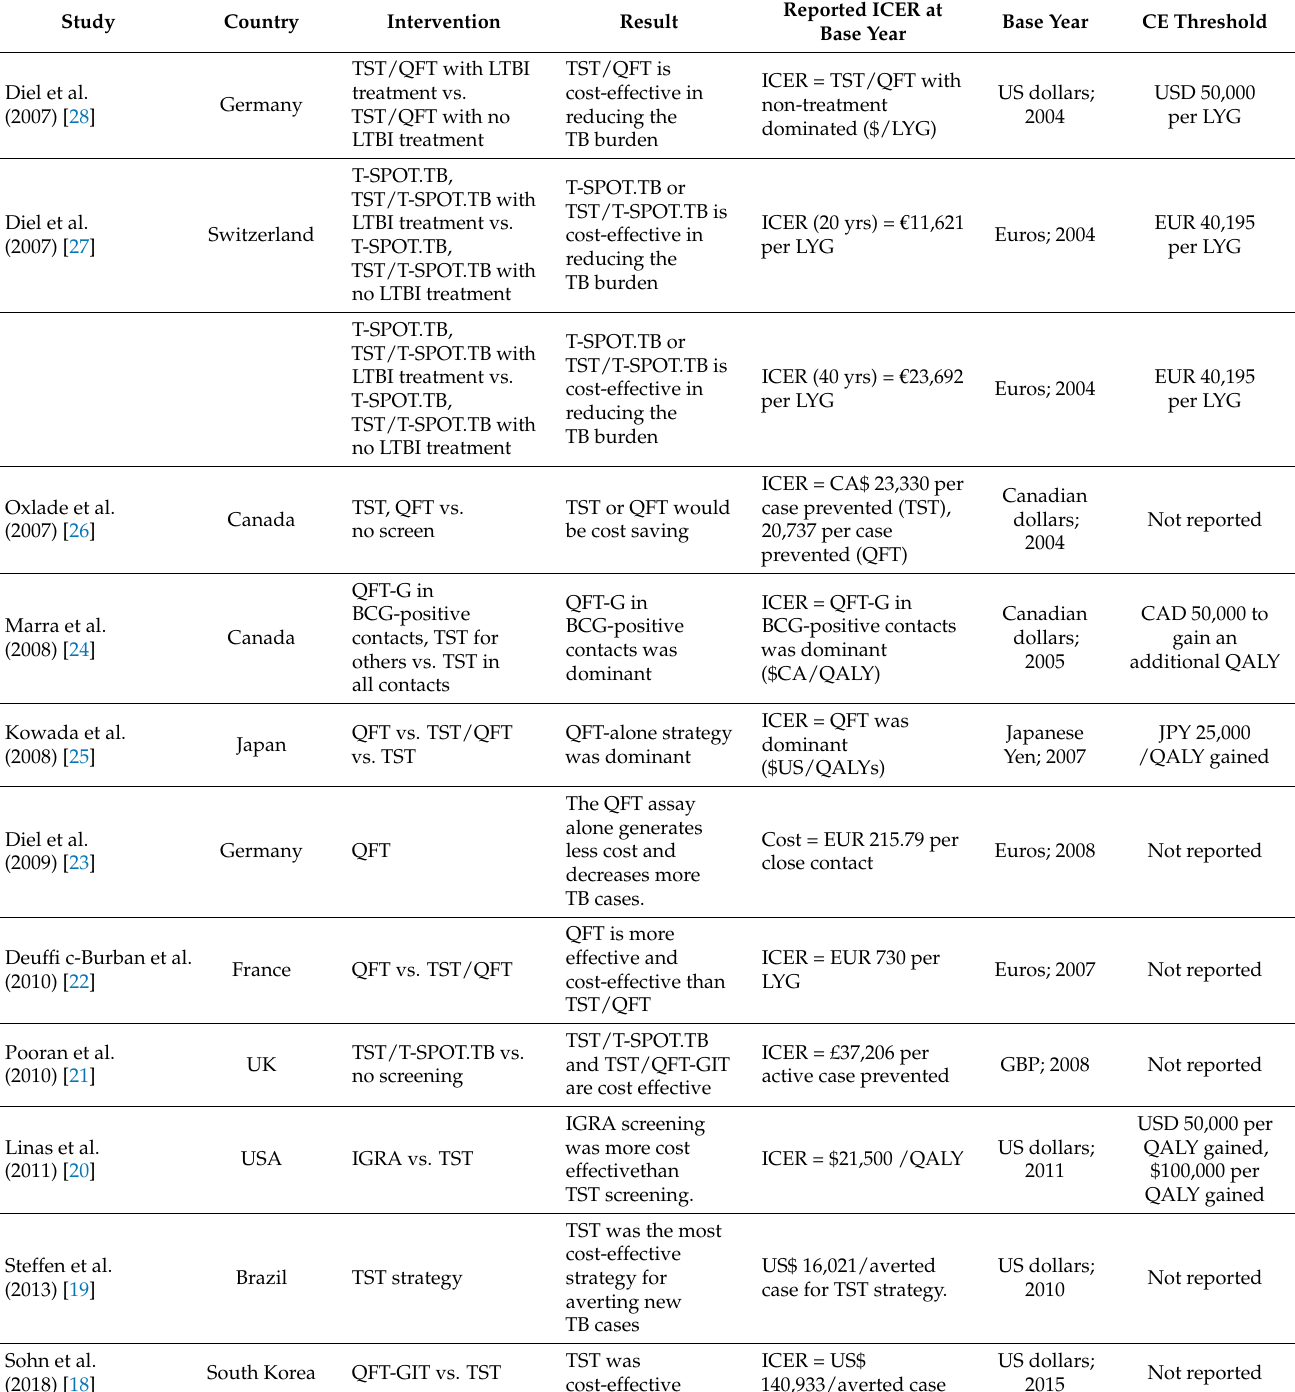
Table 2. Summary of cost-effectiveness analysis